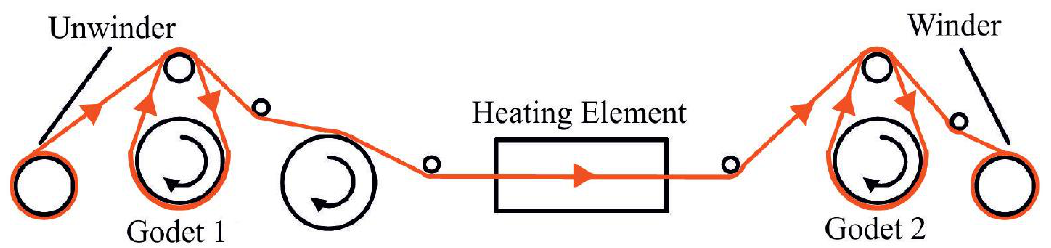
Figure 3. Drawing process as applied by DSM